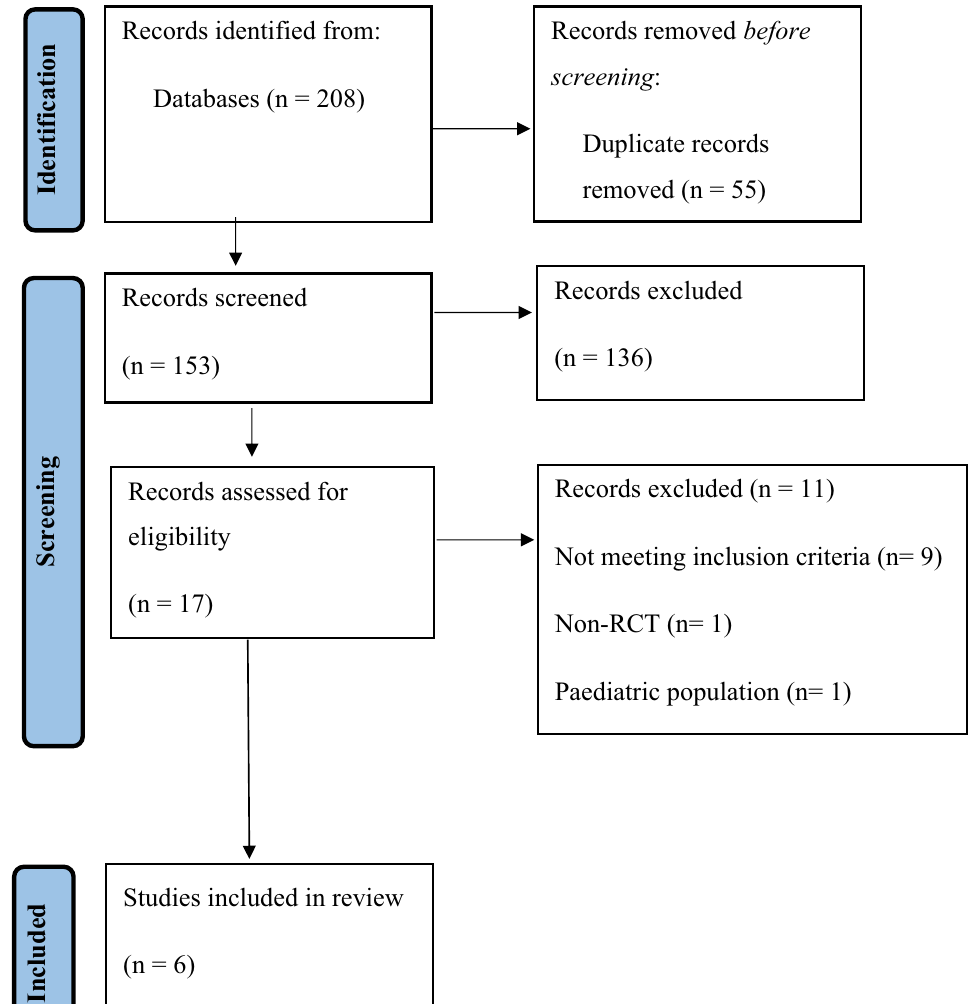
Fig. 1 Preferred reporting items for systematic reviews and meta-analysis (PRISMA) flow diagram of the